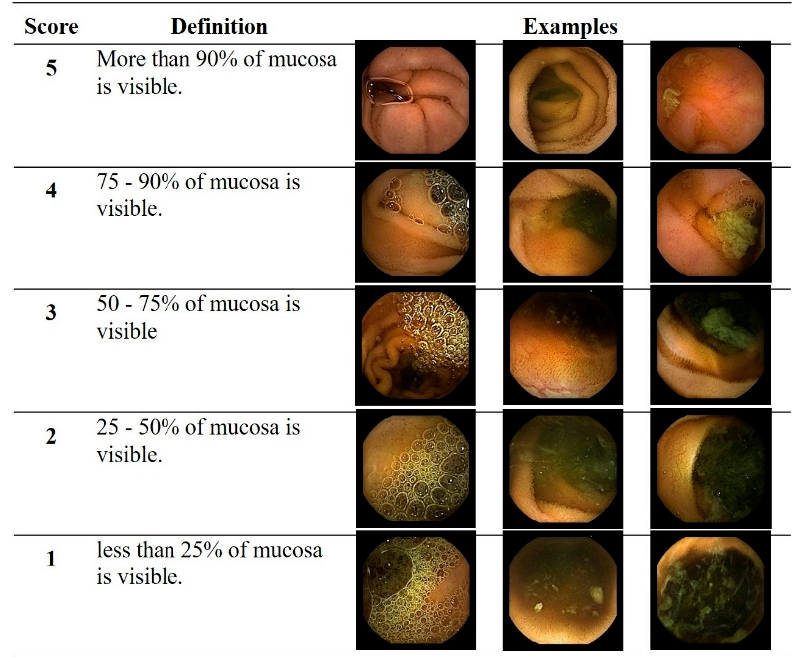
Figure 2. Cleansing score used for deep learning: A 5-point scoring method based on the propor- tion of mucosa visible.